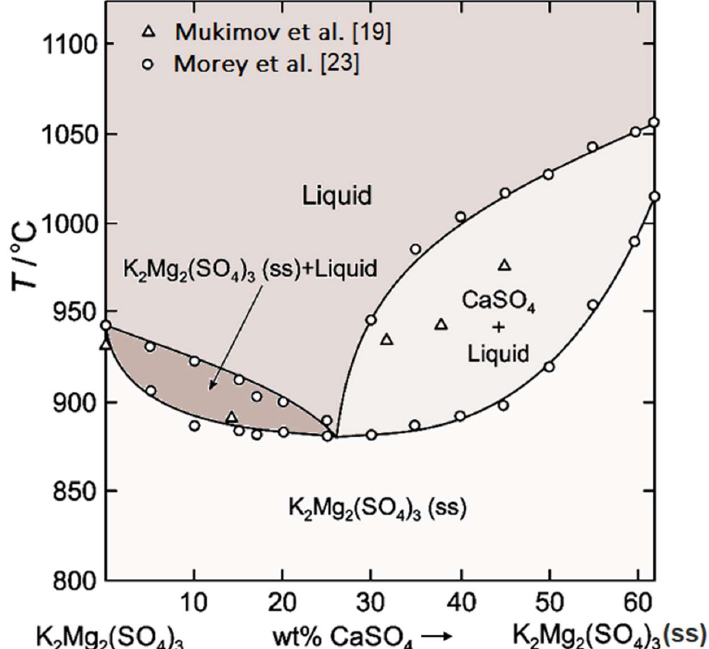
Figure 5. Phase relations on the tie line K 2 Mg 2 (SO 4 ) 3 -CaSO 4 in the K 2 SO 4 -MgSO 4 -CaSO 4 system, modified from [14].